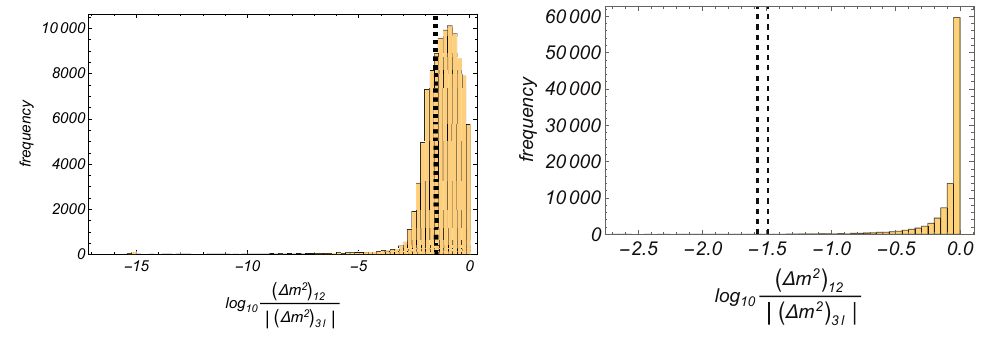
Figure 2 . Distributions of the ratio log 10 (∆ m 2 21 / ∆ m 2 3 ℓ ) under the assumptions of NH (left panel) | | and IH (right panel) in Case I. Here, we impose no cut for the three mixing angles within the 3 σ ranges. In the panels, the regions between the two vertical dashed black lines are 3 σ -favored for log 10 (∆ m 2 21 / ∆ m 2 3 ℓ ) [51]. Here we take 10 5 points for each | |